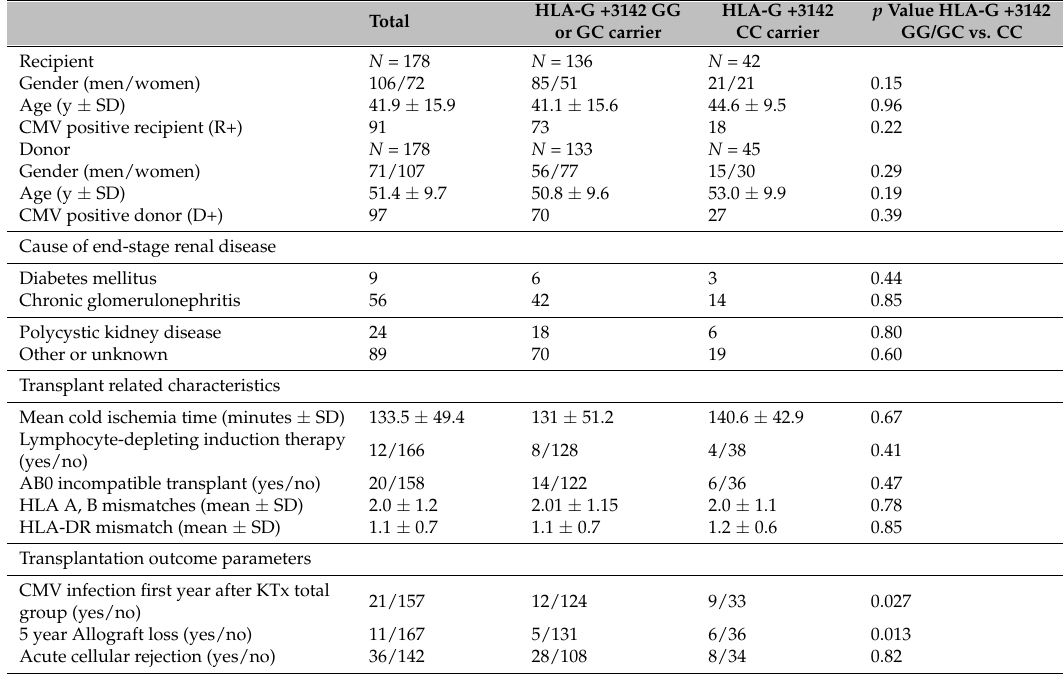
Table 3. Demographic and clinical characteristics of living-donor transplant recipients and corresponding donors at baseline. Abbreviations are as follows: y: years; SD: standard deviation, HLA: human leukocyte antigen, CMV: cytomegalovirus, R: recipient, D: donor, KTx: kidney